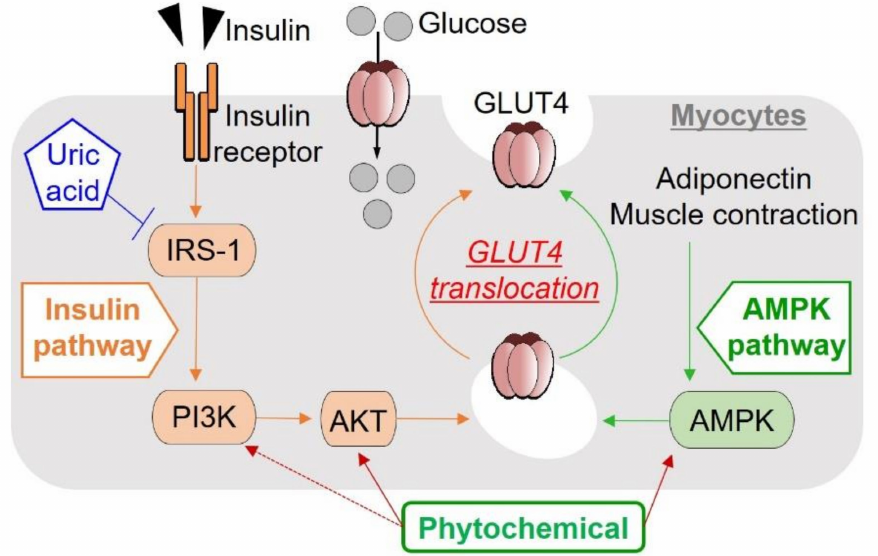
Figure 3. Schematic representation of basic insulin signaling pathways and effects of phytochemicals and uric acid. Phytochemicals, including phenolic compounds described in this review, modu- late cellular energy usage by enhancing insulin activity via AKT activiation and activation of the metabolic regulator, AMPK, cumulating in the translocation of GLUT4 to the plasma membrane and increasing glucose uptake and utilization by insulin responsive tissues such as skeletal muscle cells (modified from